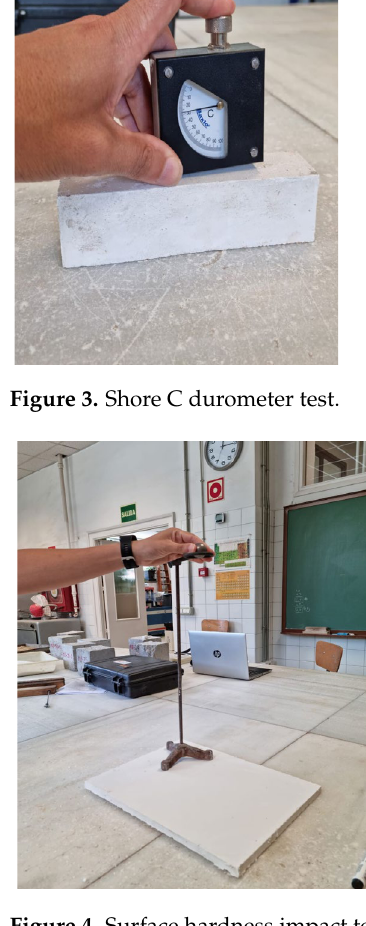
Figure 4. Surface hardness impact test.